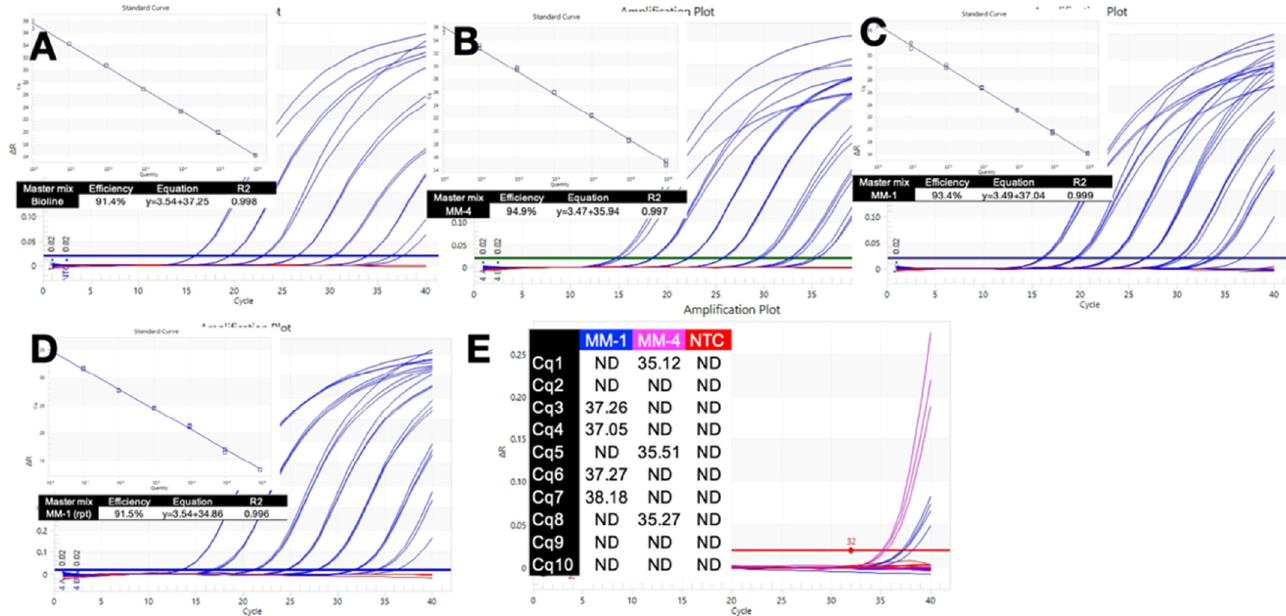
Figure 3. Comparison of PCR efficiencies. ( A ). Amplification plots, standard curve and assay parameters recorded with Bioline master mix. Red plots indicate the NTCs. ( B ). Amplification plots, standard curve and assay parameters recorded with MM-4. Red plots indicate the NTCs. ( C ). Amplification plots, standard curve and assay parameters recorded with MM-1 master mix. Red plots indicate the NTCs. ( D ). Amplification plots, standard curve and assay parameters recorded for the repeat reaction of the standard curve experiment with MM-1. Red plots indicate the NTCs. ( E ). Limits of detection for MM-1 (blue) and MM-4 (pink) using the highest dilution standard.